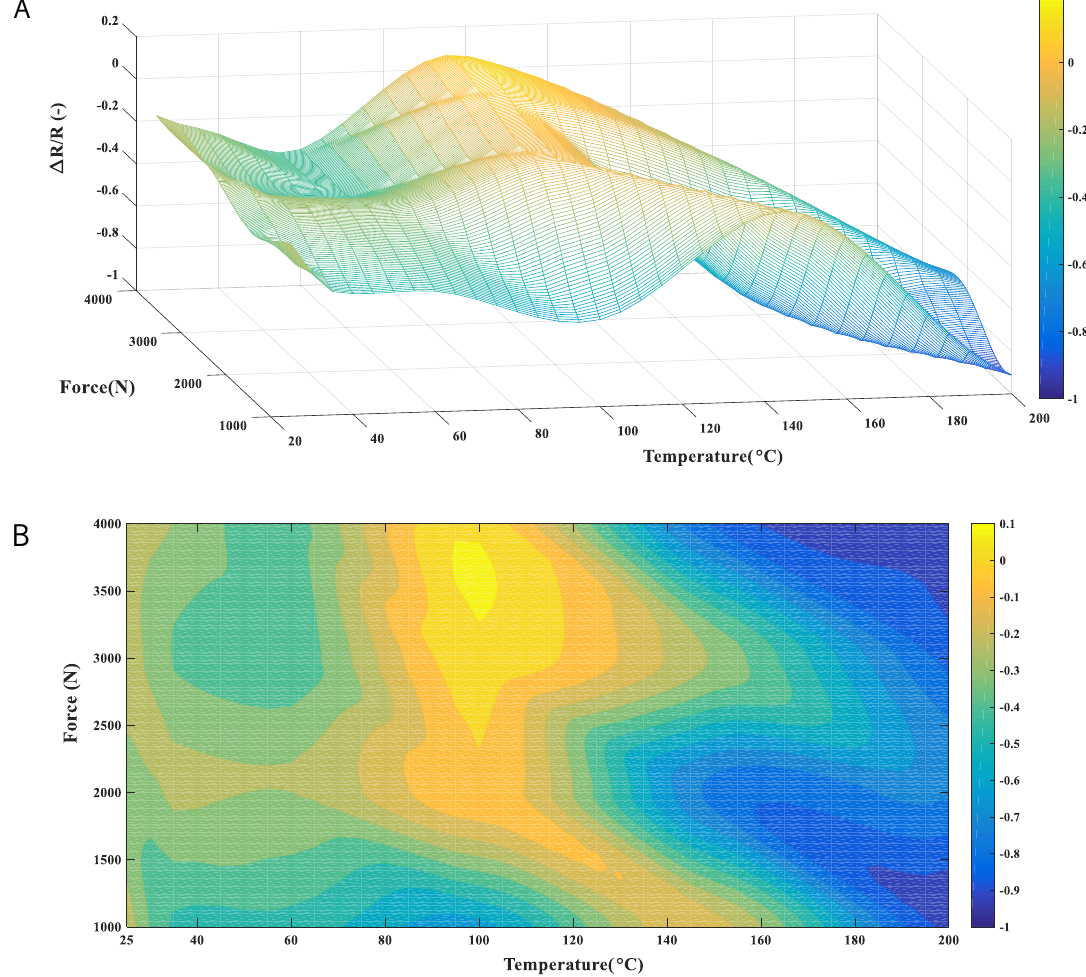
Figure 7. Contour plot for long-term predictions of the resistance variation ratio under different loading and temperature conditions in two perspectives: ( A ) oblique view. ( B ) Top view.